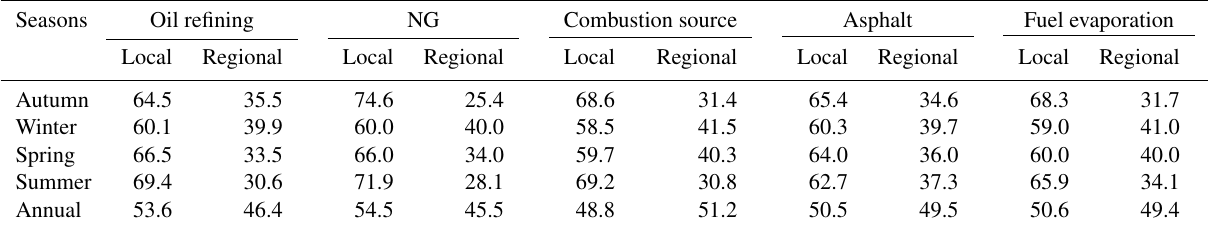
Table 3. Contributions (%) of local sources and regional transport of five sources in different